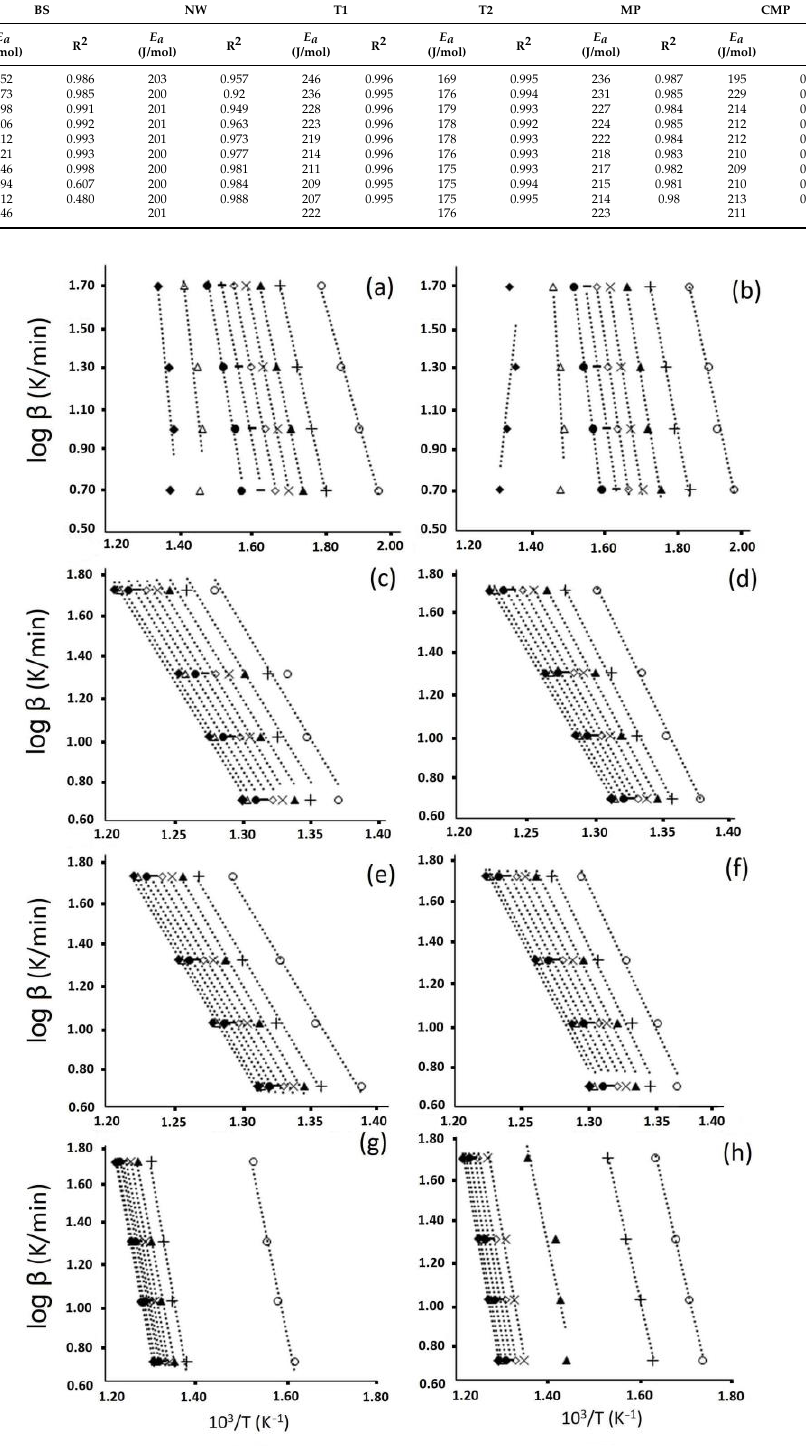
Table 4. Activation energy values ( E a ) at various conversion factors ( α ) for chaff, bluegrass straw (BS), net wrap (NW), twine 1 (T1), twine 2 (T2), mixed plastic (MP), chaff mixed plastic (CMP), and bluegrass mixed plastic (BMP) determined by TGA.